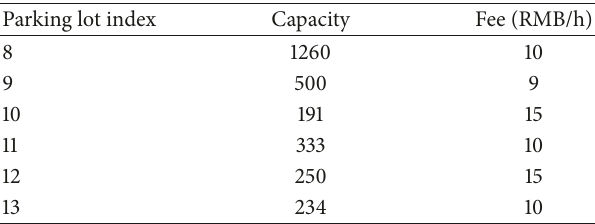
Table 1: Capacities and fees charged for the parking lots. Parking lot